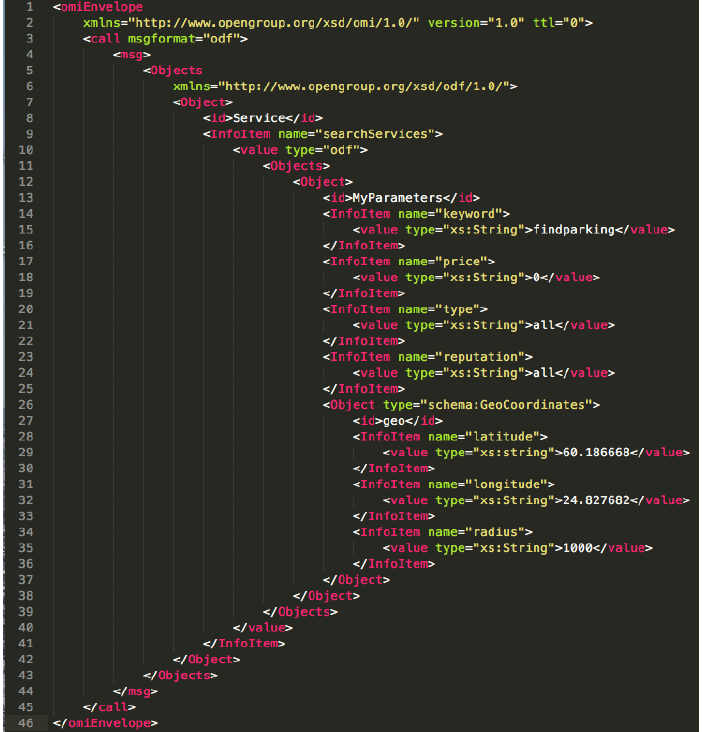
Figure 7. Searching request to IoTBnB API.